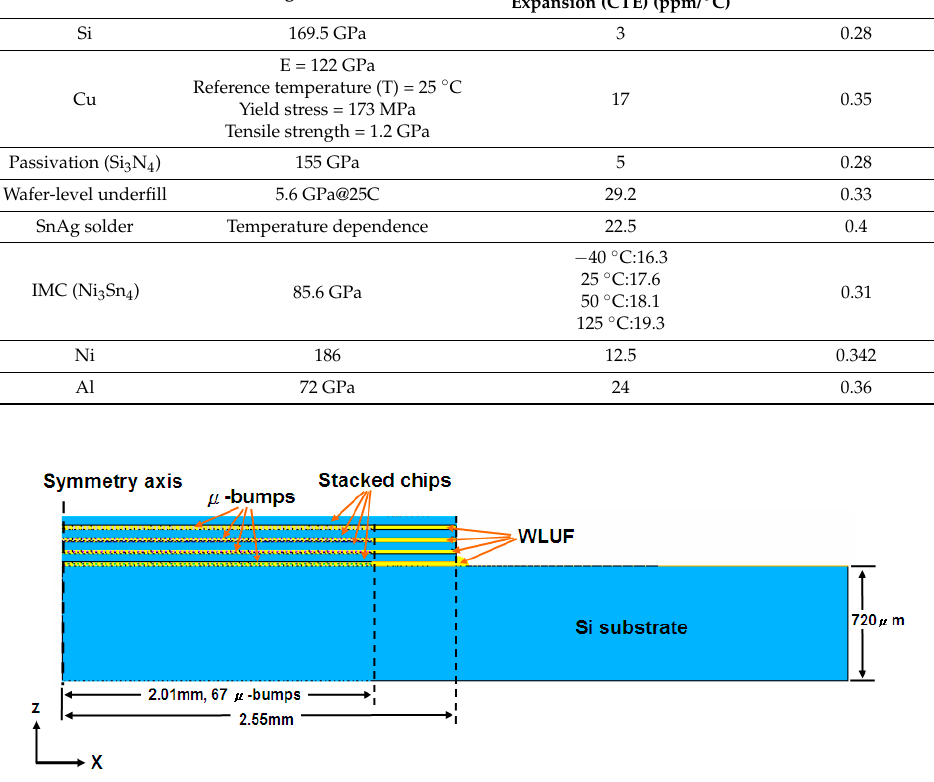
Figure 5. Half symmetry of a finite element model for a stacked chip three-dimensional-integrated circuit (3D-IC) package assembled using four chips.